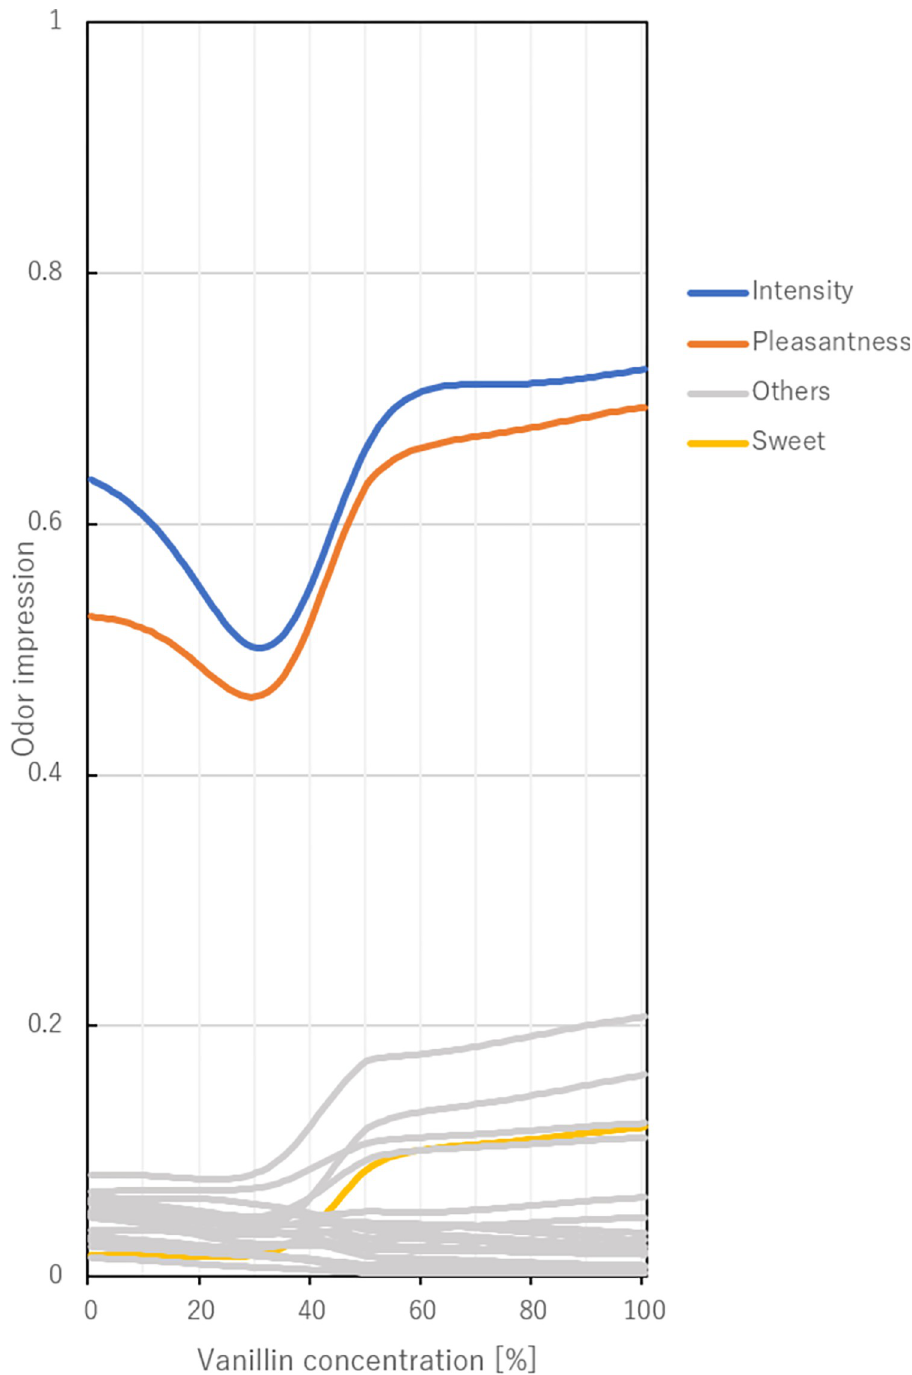
Fig 4. Changes in the scores of the odor descriptors for each mixing ratio of vanillin and citral. The horizontal axis shows the mixing ratio of vanillin. feature space obtained through the autoencoder was 0.0325, which corresponds to an average error of about 2% in the dimension of each m/z feature because the feature dimension is 70. Such mass spectrum might express mostly correct and less noisy peaks with low intensities. In